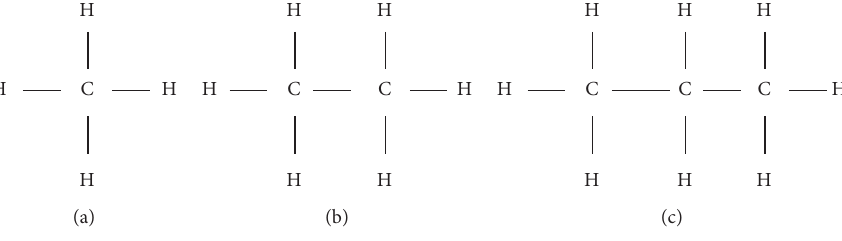
Figure 2: Lewis structure of (a) methane, (b) ethane and (c) propane.